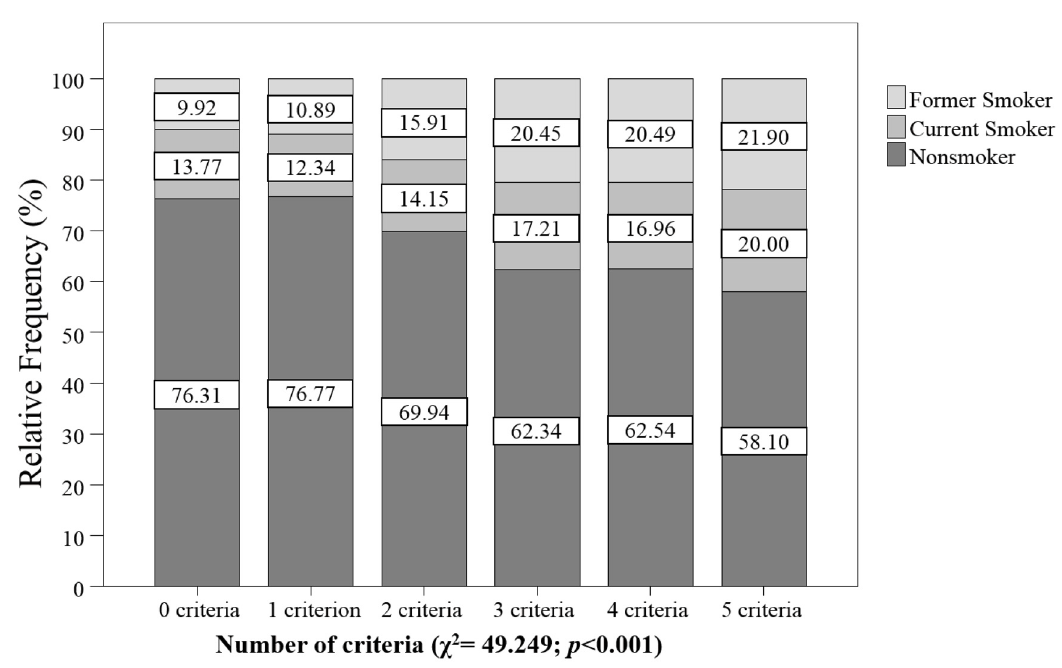
Figure 1. Smoking habit and number of metabolic syndrome criteria in subjects from Maracaibo,